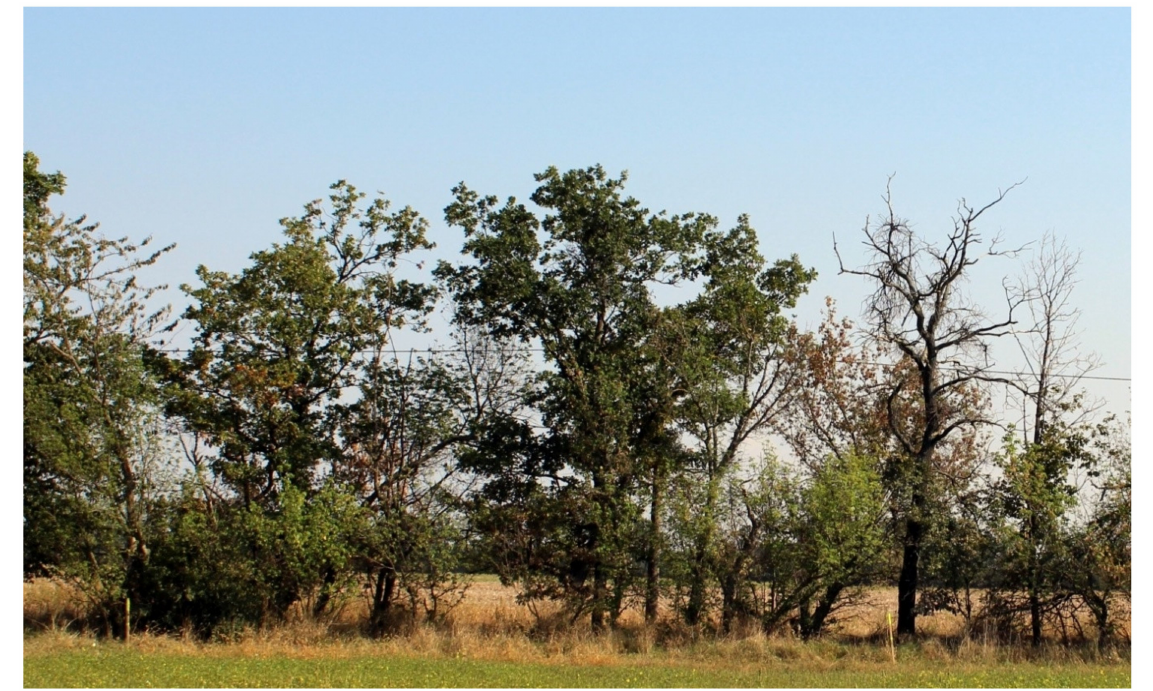
Figure 2. Nonfunctional type of